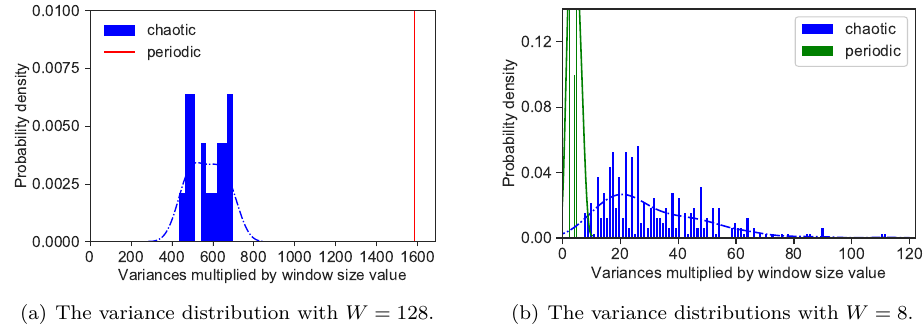
Figure 26: The variance distributions with the window size W = 128 and W =